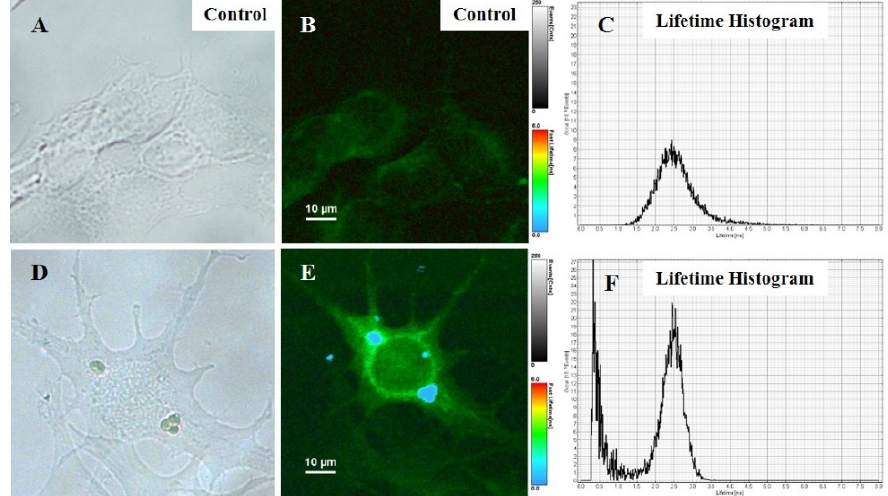
Figure 5. Bright field ( A , D ) and FLIM images ( B , E ) and their corresponding histograms of CaCO 3 (PAH)@RBITC@AN uptaken ( C , F ) by B16-F10 melanoma cells: Untreated ( A , B ) and treated with CaCO 3 (PAH)@RBITC@AN (10 microcapsules / cell) ( D , E ) for 24 h. The FLIM images denote the fluorescence lifetimes measured at each pixel and displayed as color contrast image. Excitation wavelength: 520 nm.